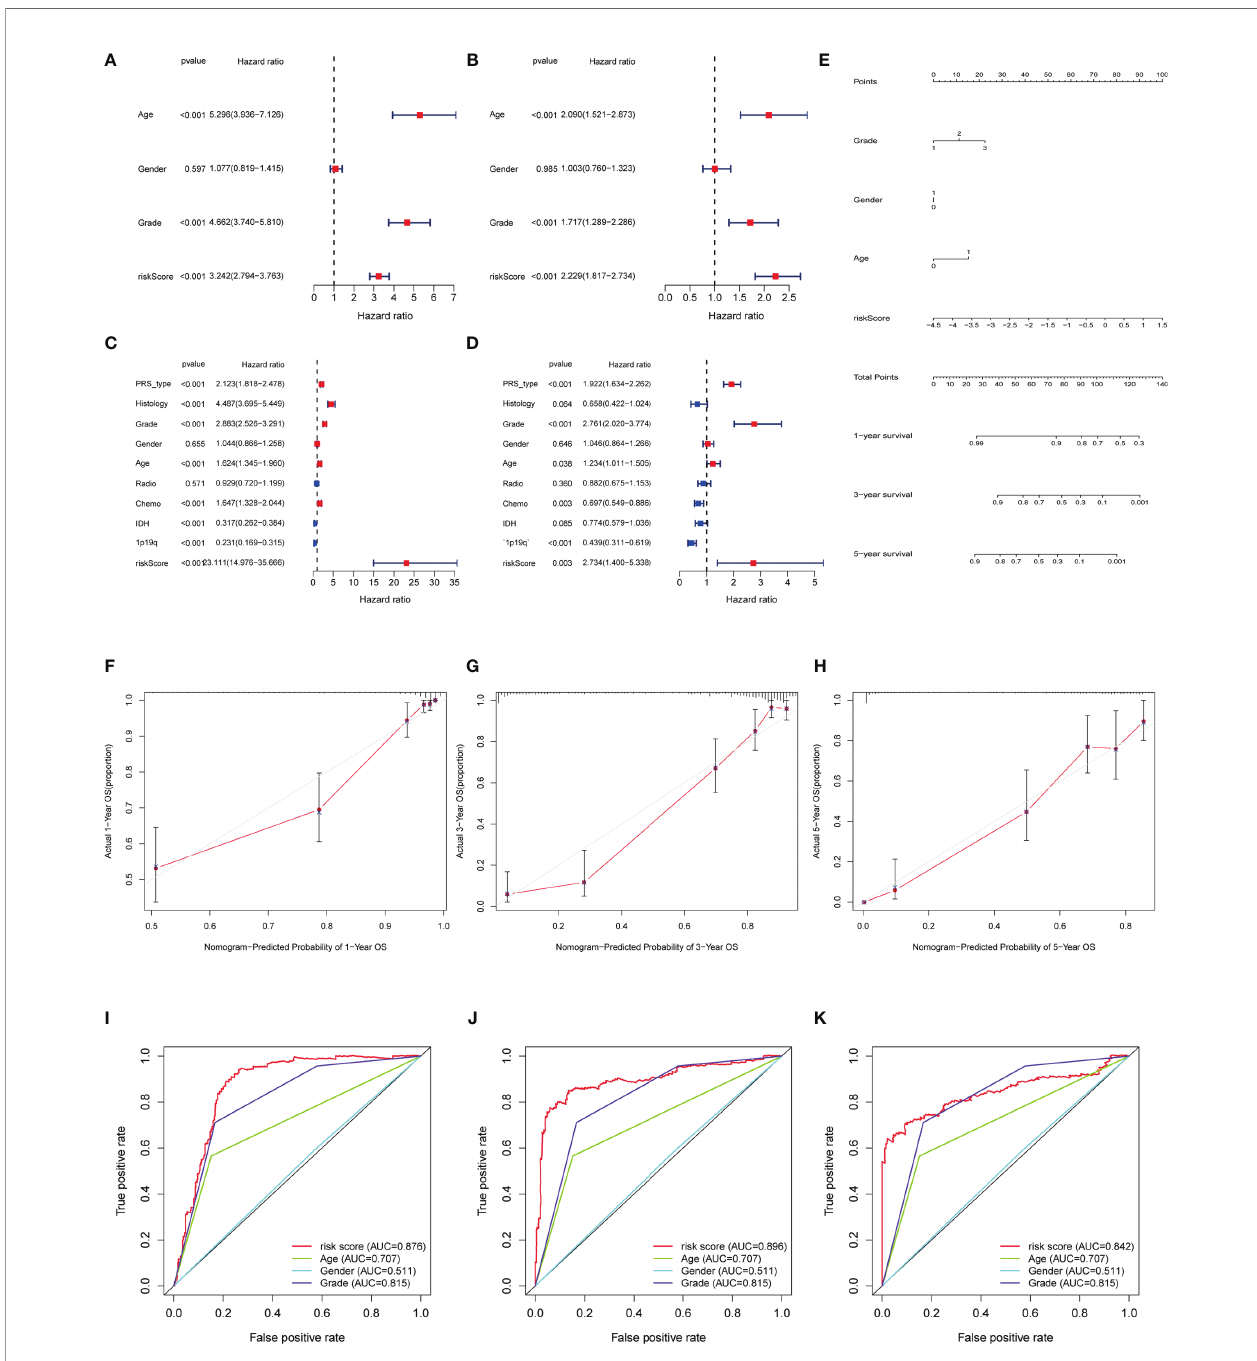
FIGURE 5 | Independent prognosis analysis of risk score. (A, C) Univariate COX Forest plot of risk score in TCGA and in CGGA. (B, D) Multivariate COX Forest plot of risk score in TCGA and CGGA. (E) Nomograph plot of predicted 1-,3-and 5-year overall survival probability based on prognosis signature. (F – H) Calibration plots of the nomogram for predicting the probability of OS at 1, 3, and 5 years in the TCGA. (I – K) Time-dependent receiver operating characteristic (ROC) curves for the nomogram, risk score, age and grade in the TCGA dataset (for predicting 1, 3, and 5-year